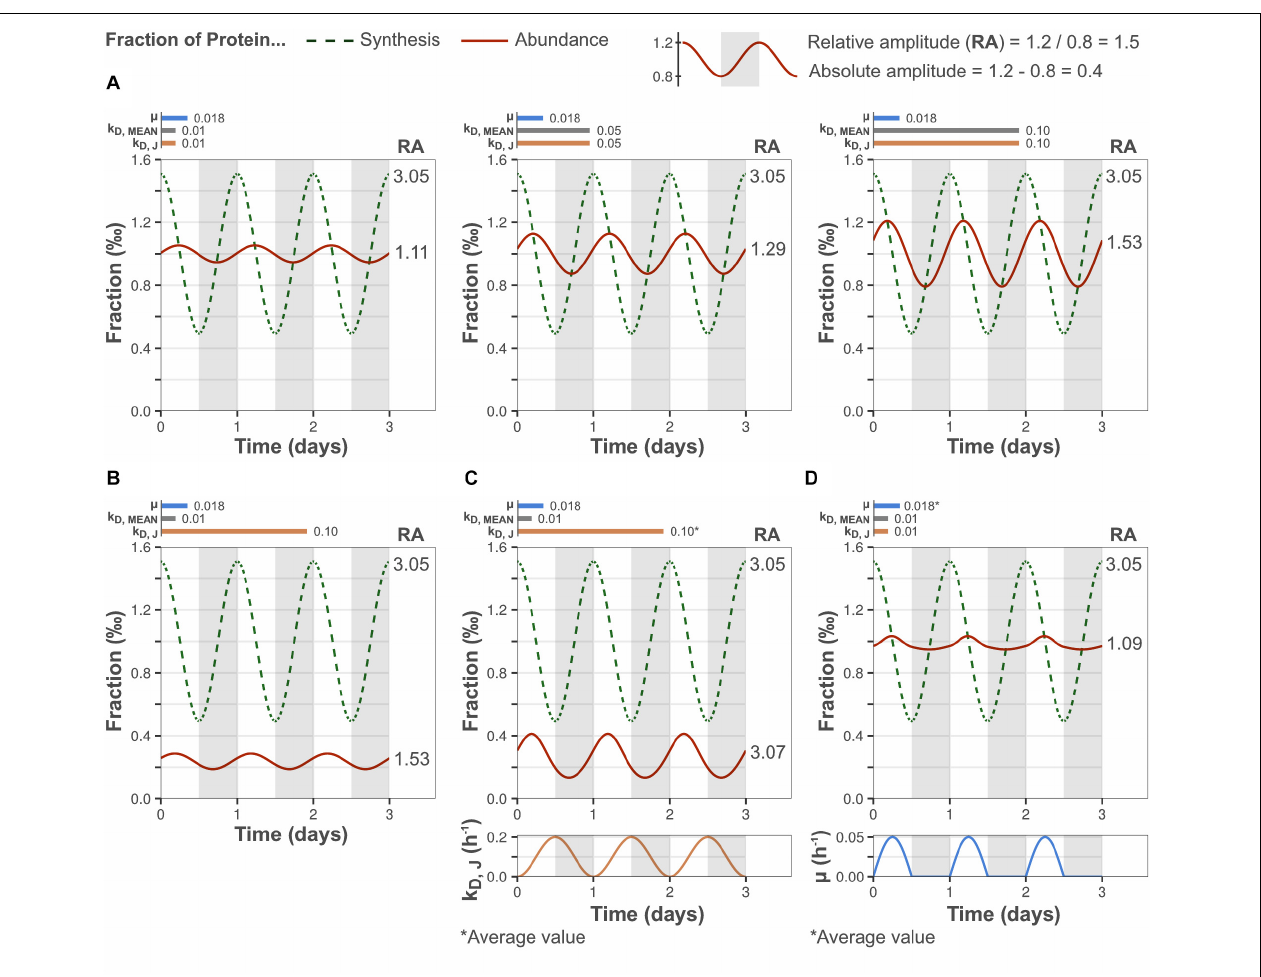
FIGURE 2 | Low protein turnover reduces the relative amplitude of diurnal protein oscillations. Y-axes display the fraction of bulk protein synthesis (dashed lines) and the fraction of bulk protein abundance (solid lines) taken up by a modeled gene J. Bar plots show the selected growth rate ( µ ), bulk protein degradation rate (k D , MEAN ) and gene-specific protein degradation rate (k D , J ). (A) Higher bulk protein turnover ( µ + k D , MEAN ) increased the relative amplitude (RA) of diurnal protein oscillations, by increasing the absolute amplitude. k D , J was set equal to k D , MEAN to simulate the behavior of an “average” gene. (B) Increasing the gene-specific turnover, by setting the gene-specific protein degradation rate greater than bulk protein degradation rate (k D , J > k D , MEAN ; gene-specific turnover > bulk turnover), increased the relative protein amplitude by decreasing the daily average protein abundance. However, the absolute protein amplitude was not affected (compare A , left panel). (C) A high and fluctuating gene-specific protein degradation that is anticorrelated to the protein synthesis rate increased the relative protein amplitude by increased absolute protein amplitude, and by reduced daily average protein abundance. (D) A diurnally fluctuating growth rate had no significant effect on the protein amplitude, although the diurnal pattern was altered. The daily average growth rate was equal to the set value in Figure 1A . The growth rate curve was based on the experimentally determined pattern.